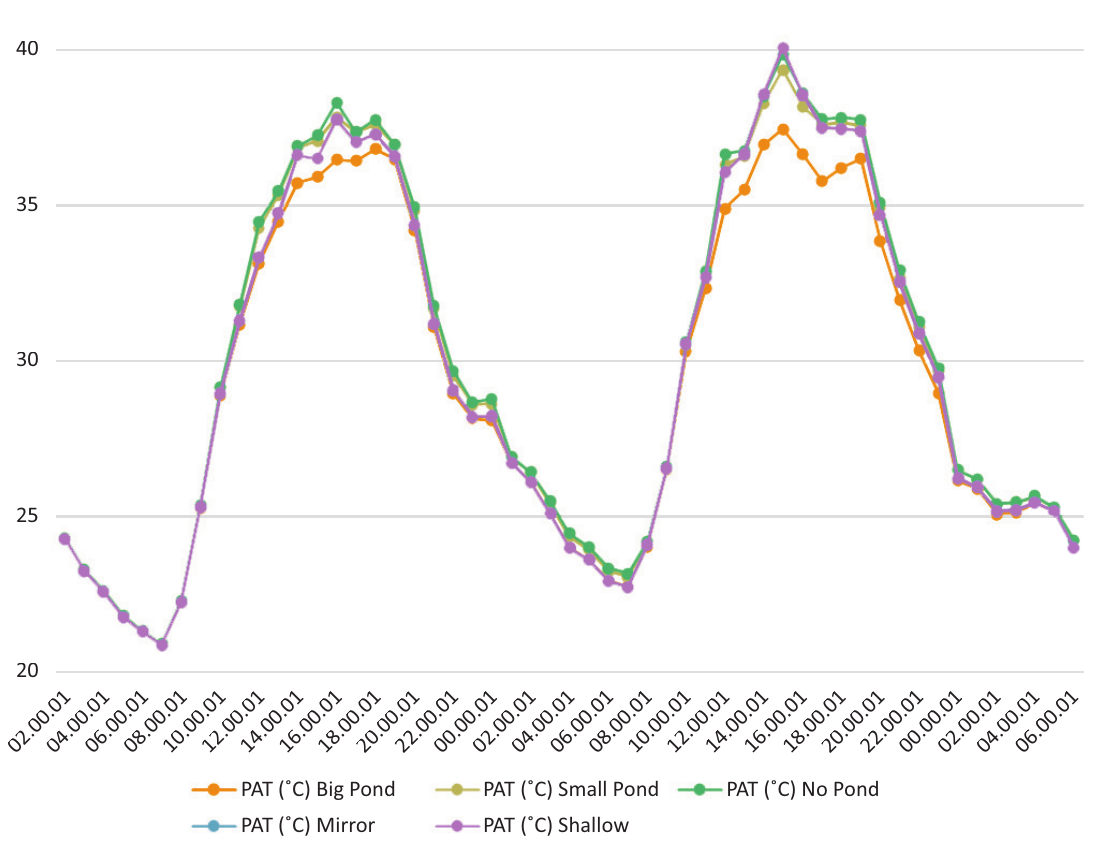
Figure 5. Comparison of the influence of waterbodies on the PAT, depending on size and depth using ENVI‐met software. Notes: Pond dimensions—Big pond (28 m wide × 54 m long × 4.5 m deep), small pond (8 m × 14 m × 4.5 m), shallow pond (28 m × 54 m × 0.5 m), and mirror pond (28 m × 54 m × 0.04